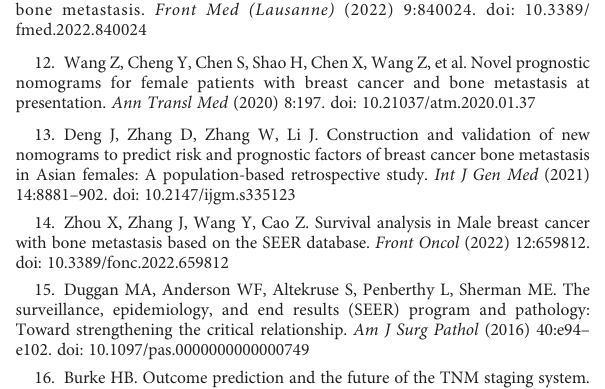
SUPPLEMENTARY FIGURE S1 A visualized dynamic diagnostic nomogram for estimating the risk of BM in MBC patients. 95% con fi dence interval for the probabilities of estimating the risk of BM in this patient under these conditions (T1 stage, T2 stage, T3 stage, T4 stage) (B) . Numerical summary for estimating the risk of BM in this patient under the above conditions (C) .